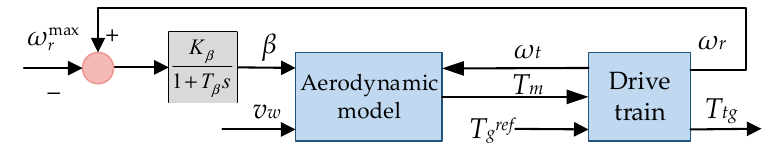
Figure 3. Wind power